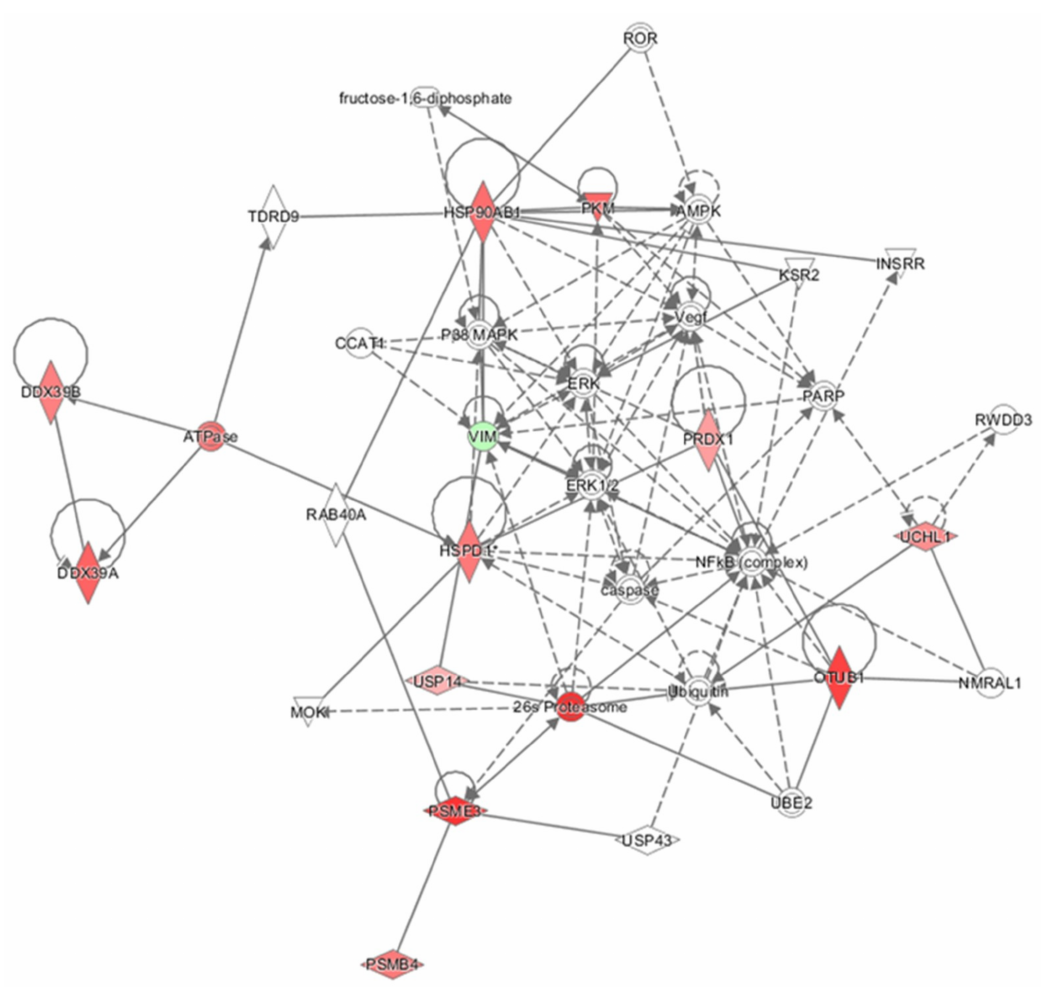
Figure 6. Functional Network. Proteins differentially expressed resulting from the oleocanthal + H 2 O 2 vs. H 2 O 2 comparison were functionally analyzed through the use of QIAGEN’s Ingenuity Pathway Analysis. Network describes functional relationships among proteins based on known associations in the literature. Solid line: direct interaction; dotted line: indirect interaction. * This protein has been identified in many